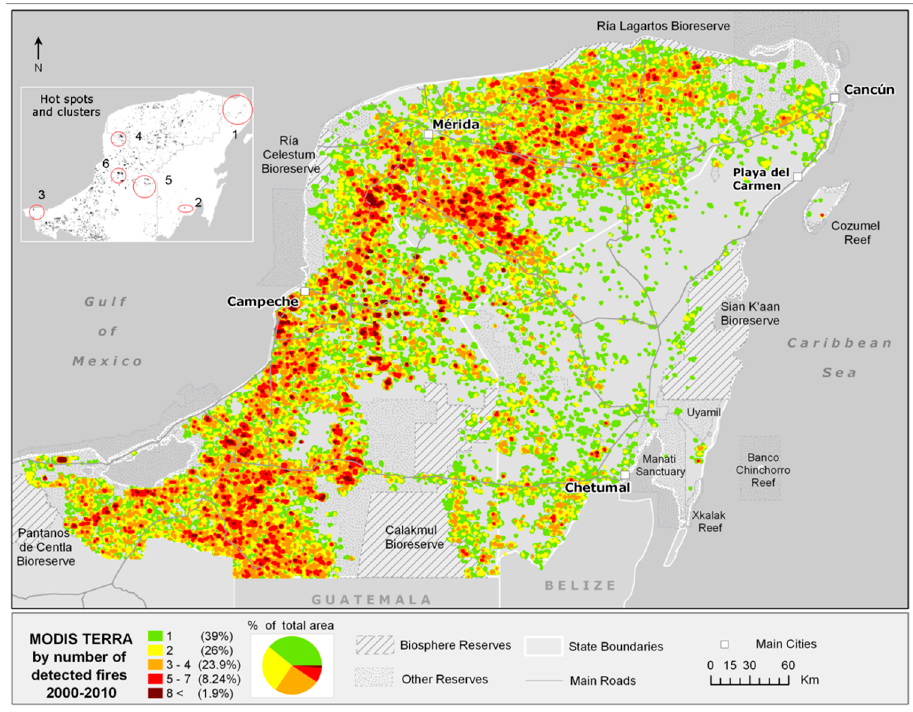
Figure 2. Fire frequency map, 2000–2010 MODIS TERRA-only series. Significant Getis-Ord Gi statistic (0.05 level) hot spots and LISA-based clusters are shown in inset (upper left). 1 = 2006 post-hurricane Wilma fires, and urban development related fires; 2 and 5 = Mennonite land clearing for commercial maize cultivation; 3 = PEMEX oil processing plant; and, 4 and 6 = high yield commercial corn and bean cultivation.